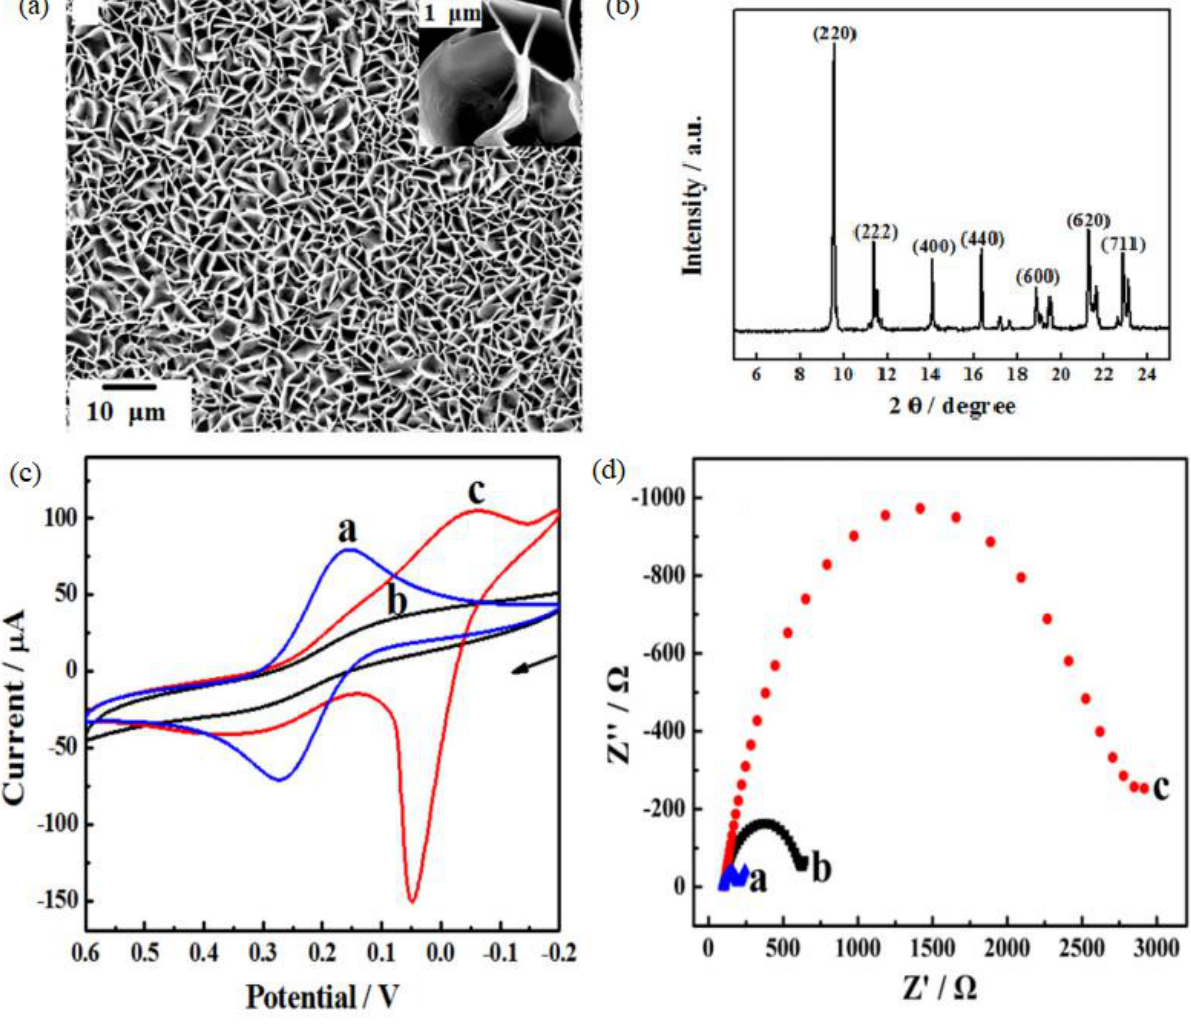
Figure 8. ( a ) Low magnification SEM images, insert high-magnification SEM image of Cu − MOF/graphene electrode, ( b ) XRD pattern of Cu − MOF/graphene-modified bare glassy carbon (GC) electrode, ( c ) Cyclic Voltammetry (CV) of 1.0 × 10 − 3 mol L − 1 K 3 [Fe(CN) 6 ], and ( d ) Nyquist plots of EIS in 5.0 × 10 − 3 mol L − 1 Fe(CN) 63 − /4 − containing 0.1 mol L − 1 at different electrodes (a. bare, b. graphene-modified, and c. Cu − MOF/graphene-modified GC electrodes). Reproduced with permission from [25].